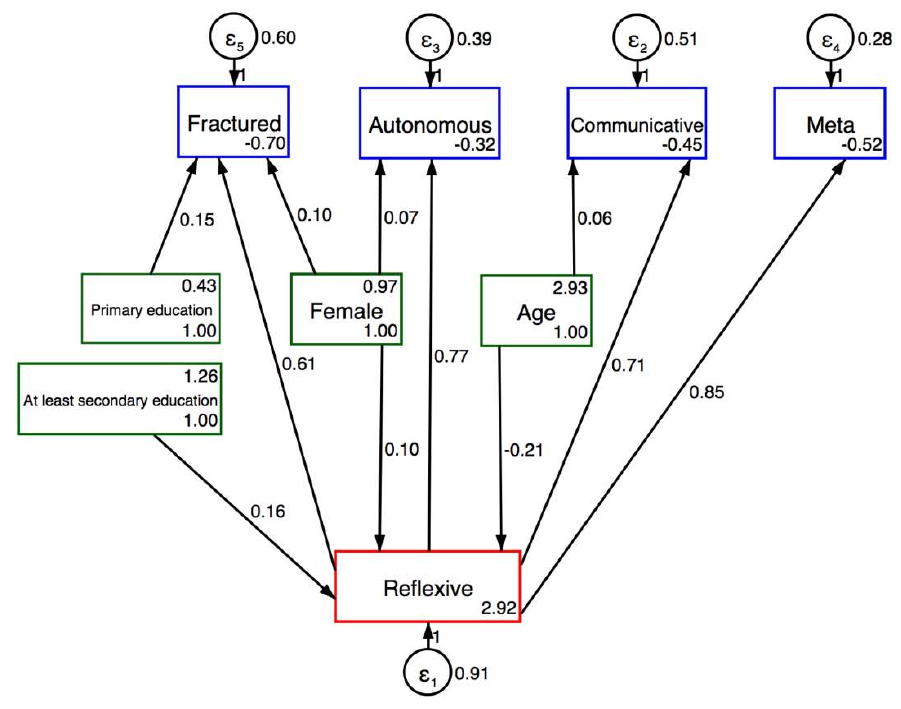
Figure 5. Reflexivity levels for different generations. Table 5. Standardised coefficients, significance levels, and variances explained for the variables in the reflexivity model.